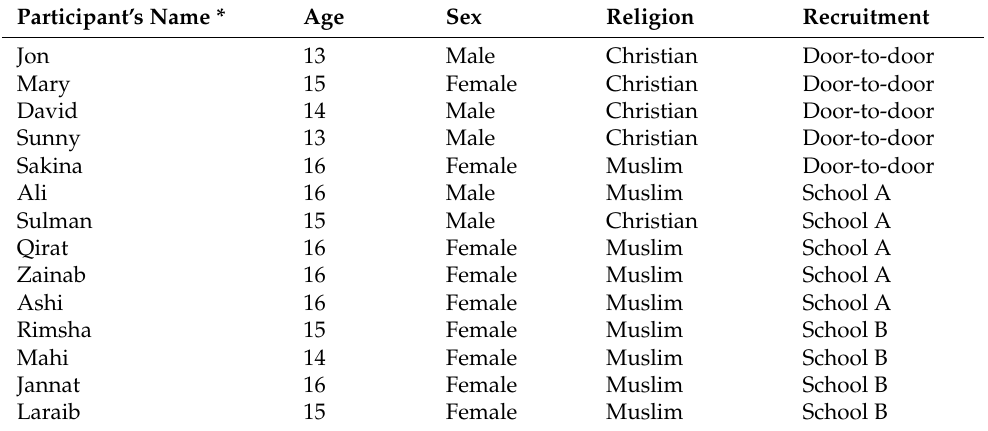
Table 1. Participants